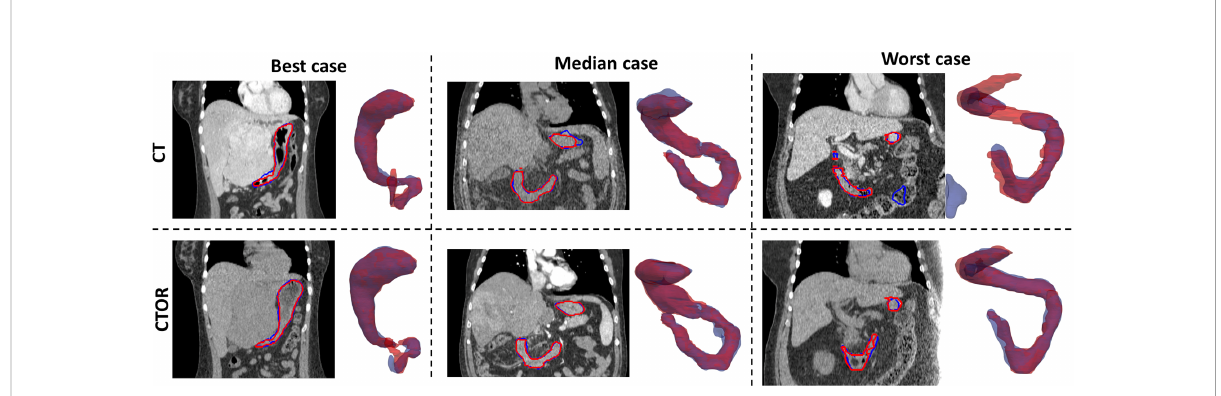
FIGURE 1 Representation for 3 test cases of manually-drawn (in red) and auto-segmented (in blue) contours of the stomach and duodenum combination on transversal slices of the images and 3D perspective (posterior to anterior direction). Top row: CT scans; Bottom row: CTOR